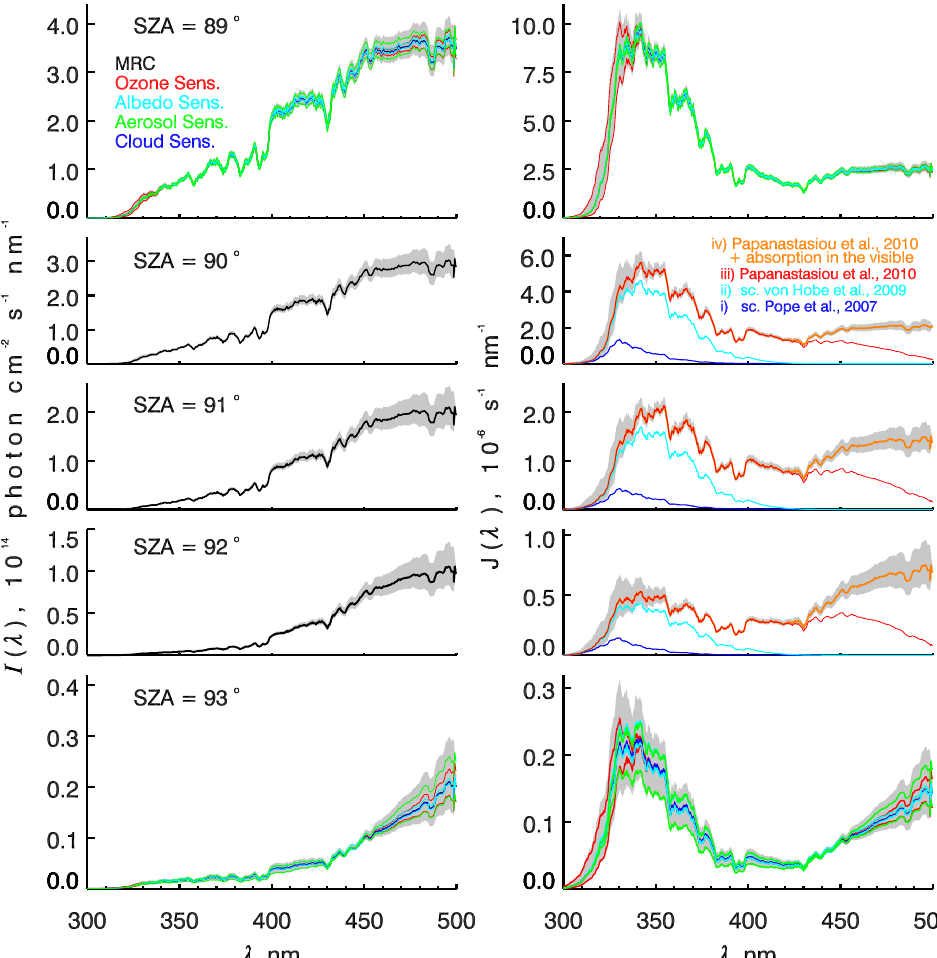
Fig. 4. Actinic fluxes and corresponding J ClOOCl (λ) values with sensitivities for five different solar zenith angles. In the left panels, black lines represent the most realistic case of actinic flux and in right panels the lines correspond to J ClOOCl (λ) based on various σ ClOOCl cases. The grey areas in all panels show the maximum uncertainties from a total of 81 different scenarios with respect to ozone, albedo, aerosol and clouds. J ClOOCl (λ) with uncertainty range is only shown for the Papanastasiou et al. (2009) cross sections extended into the visible where the sensitivity is the largest. For comparison, J ClOOCl (λ) calculated with the other cross sections (same colours as in Fig. 1) for the MRC are shown in the 90 ◦ , 91 ◦ and 92 ◦ SZA panels. For 89 ◦ and 93 ◦ , the coloured lines show the individual sensitivities (all other parameters as in the MRC except for albedo, where the sensitivity is shown for a cloud free case) towards ozone (red), albedo (cyan), aerosol (green) and clouds (blue). See text in Sect. 2.5 for a description how these parameters were